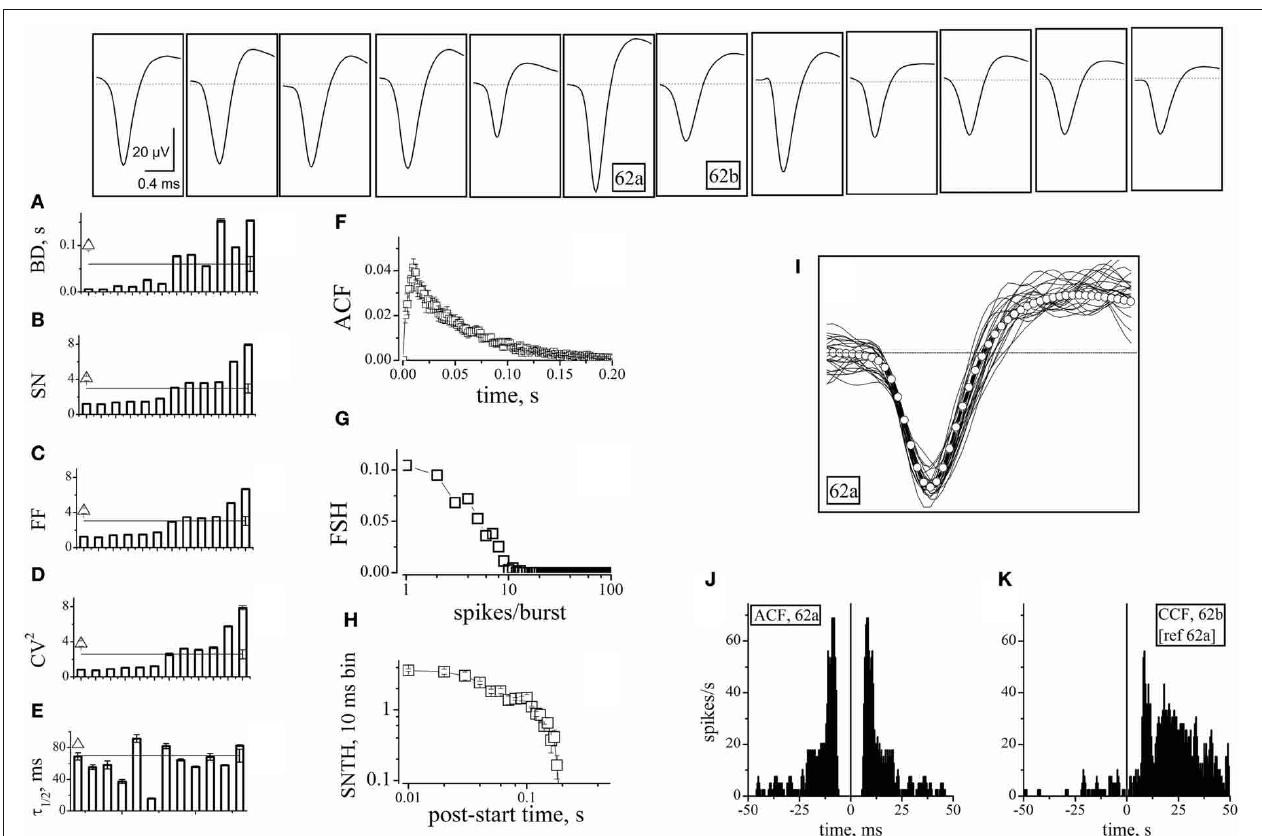
FIGURE 3 | Properties of units identified from electrodes devoid of GFP + cells. The upper insets show the averaged (5400s) waveshapes of spikes assigned to units recorded from electrodes devoid of GFP + cells. (A–E) Plots of BD, SN, FF, CV 2 , and τ 1 / 2 , respectively, computed from data segments of 2h recordings consisting in ∼ 160 bursts, for each of the 12 units whose spike template is shown in the upward insets. In the same plot, the lines (with error bars at the right end) represent the corresponding mean values. The open triangles shown on the left of panels A–E are average values obtained by using the software mentioned when describing Figure 4 . (F) The ACF of then 12 units mean. (G) The FSH of the 12 units mean. (H) The SNTH of the 12 units mean. (I) Forty superimposed spikes from unit 62a (lines) and the